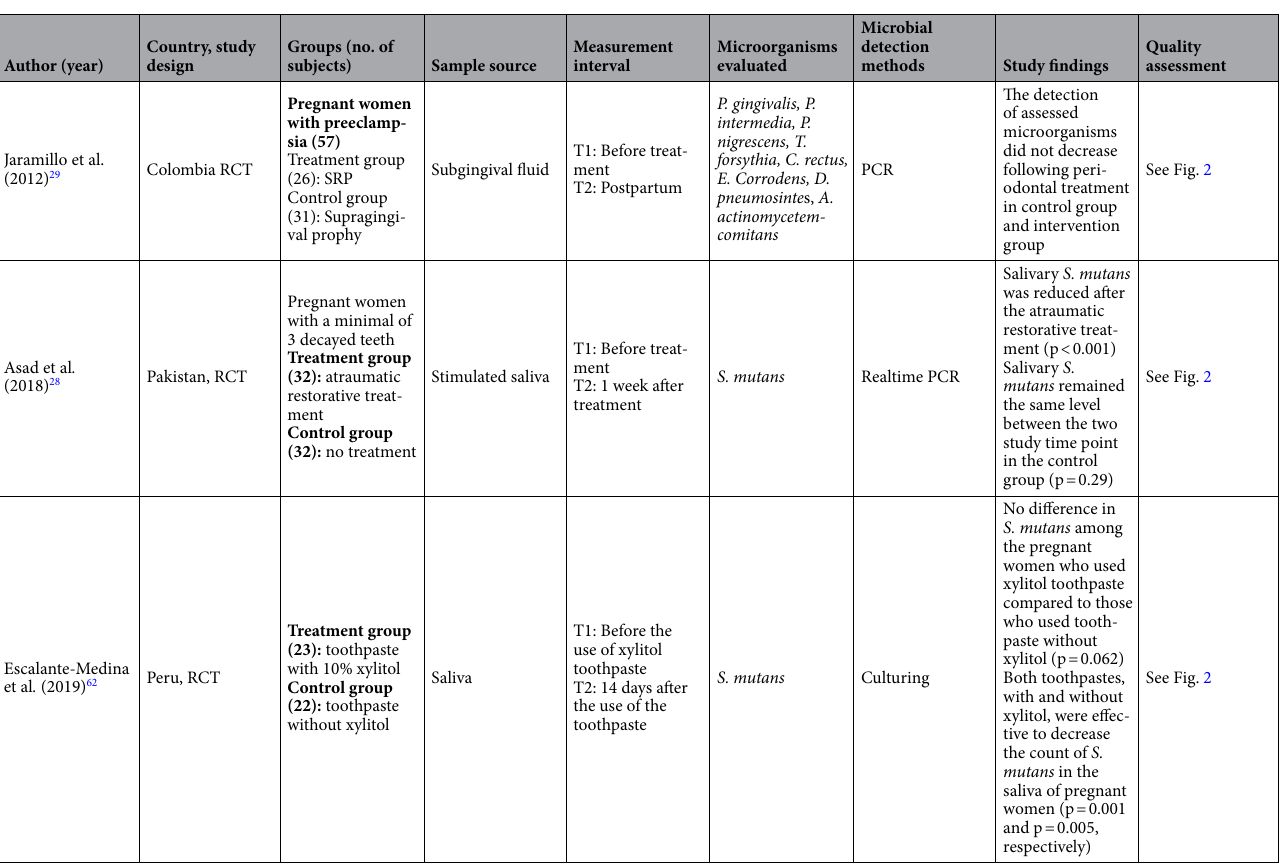
Table 3. Oral microbial differences responding to prenatal dental